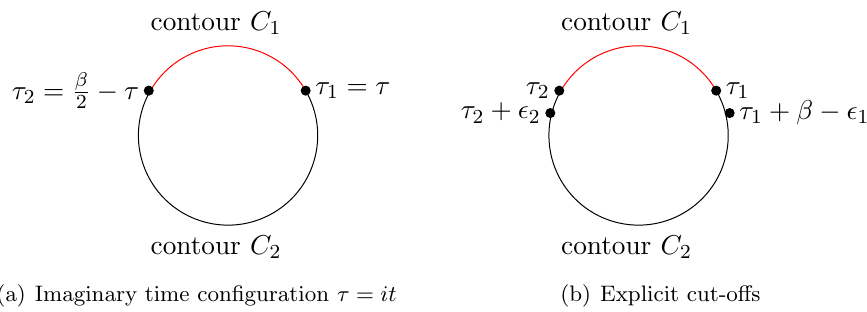
Figure 4 . (a) The imaginary time contour involved in the entanglement entropy calculation.